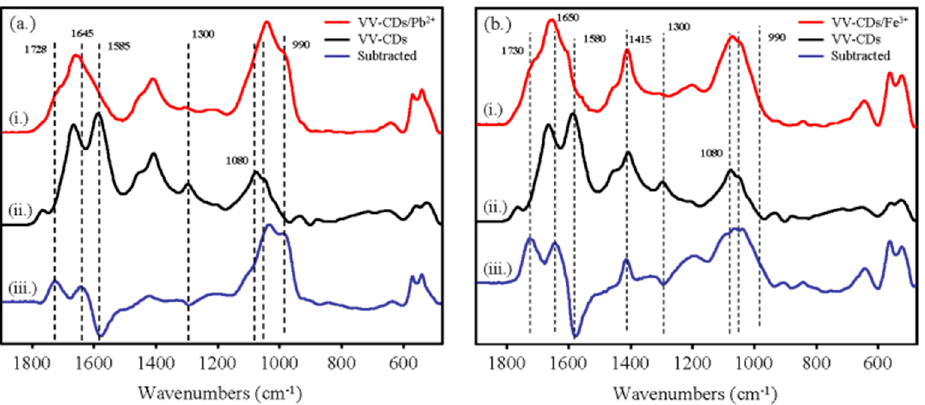
Figure 9. FTIR absorption spectra of VV-CDs and after interacting with ( a ) Pb 2+ ions and ( b ) Fe 3+